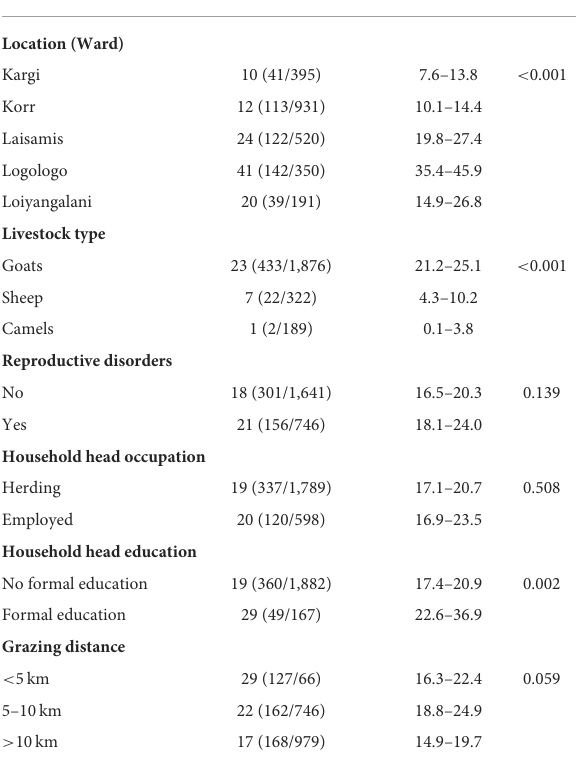
TABLE 2 Brucellosis seroprevalence in animals by socio-demographic characteristics.